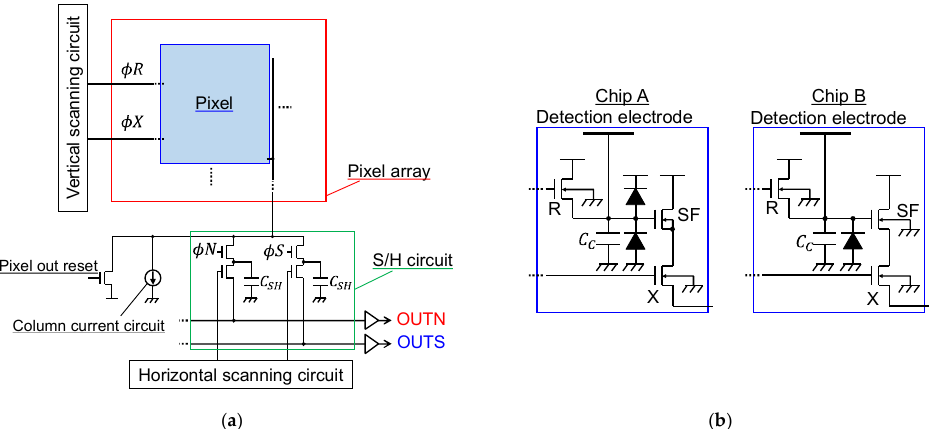
Figure 2. The schematics of the two chips: ( a ) the circuit block diagram; ( b ) the circuit schematic of the pixels.